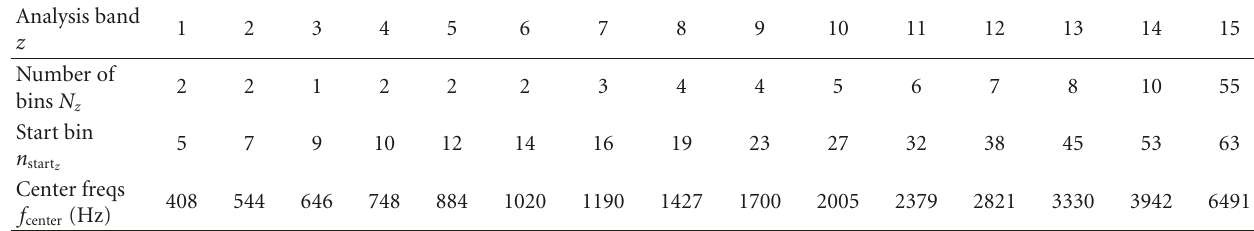
Figure 1: Block diagram illustrating SpecRes. Table 1: Number of FFT bins related to each analysis band and its associated center frequencies in Hz. The FFT bins have been grouped in order to match the center frequencies of the standard HiRes filterbank used in clinical routine